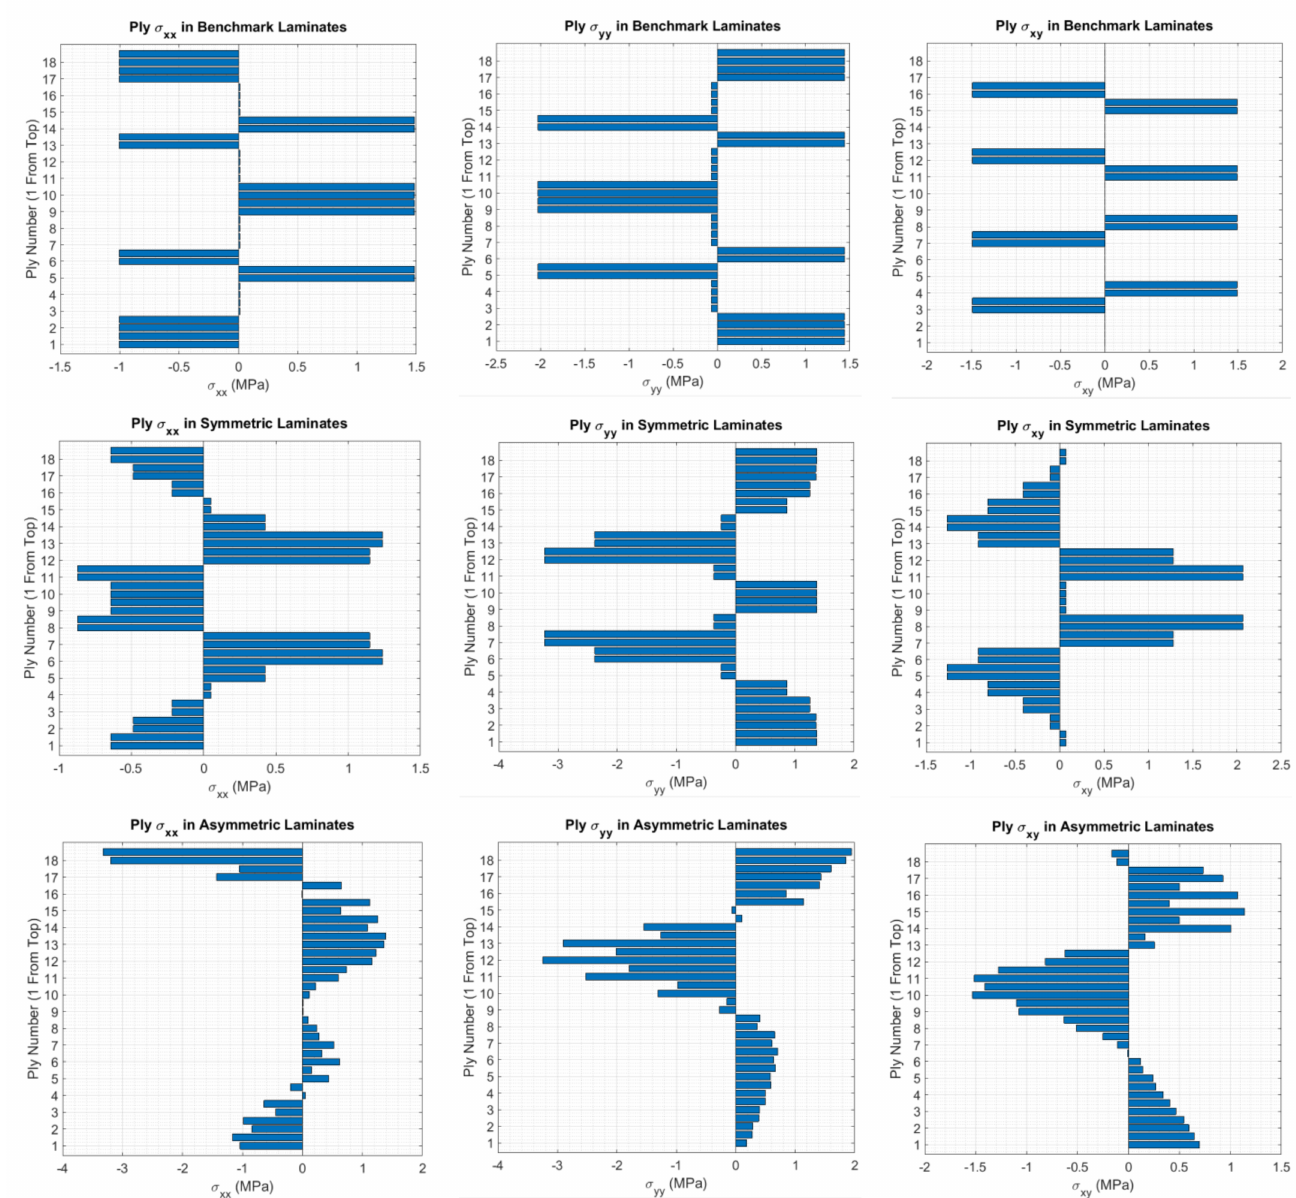
Figure A1. Laminate residual thermal stresses. As can be seen from this figure, the non-zero [B] matrix in the FGPA laminates causes in-plane to out-of-plane coupling of forces and deformations, leading to thermal-induced warpage and twist. Consequently, the thermal residual stress on FGPA samples requires a custom cure cycle to be minimised with a low curing temperature and cool rate. FGPS configuration, instead, was designed using a greater variable ply angle and a symmetrical layup obtaining a zero [B] matrix that generates no thermal residual stress on the laminate geometry during the cure (Figure